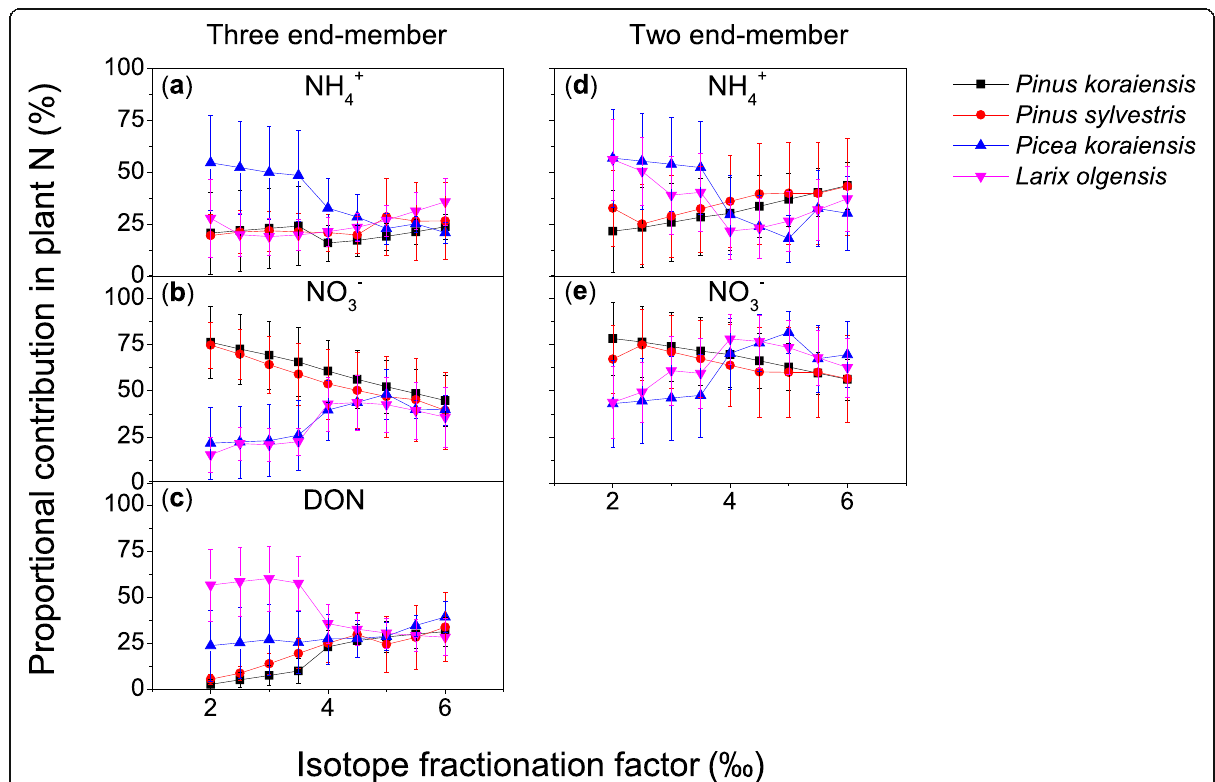
Fig. 6 Sensitivity analysis of the proportion of plant N derived from different N sources to the internal plant isotope effect by three and two end-member calculation. ( a ), ( b ), and ( c ) show the effect on the proportional contributions of different N sources to total N uptake by three end-member calculation, when considering combined isotope effect associated with N uptake, transportation and N assimilation (from 2 ‰ to 6 ‰ ); ( d ) and ( e ) show the proportional contributions of different N sources to total N uptake by two end-member